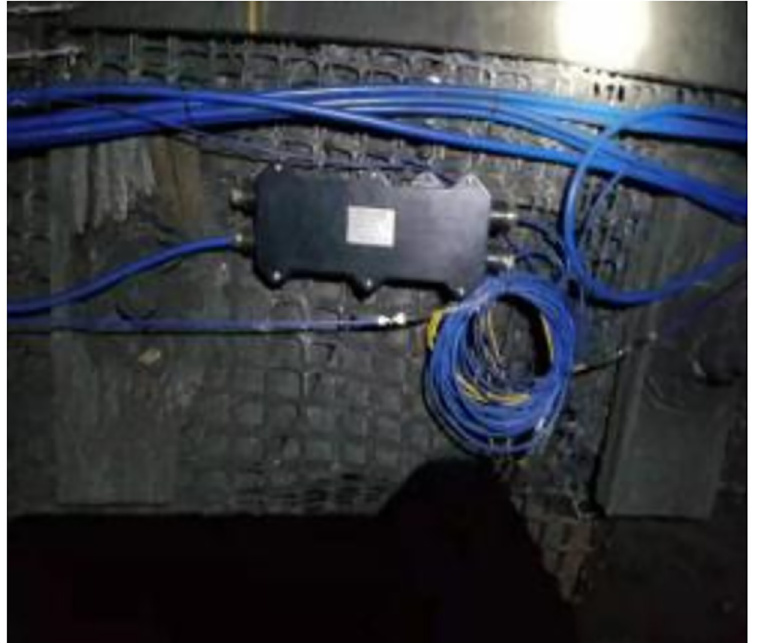
Fig 22. One of pictures of monitoring of connection lines.